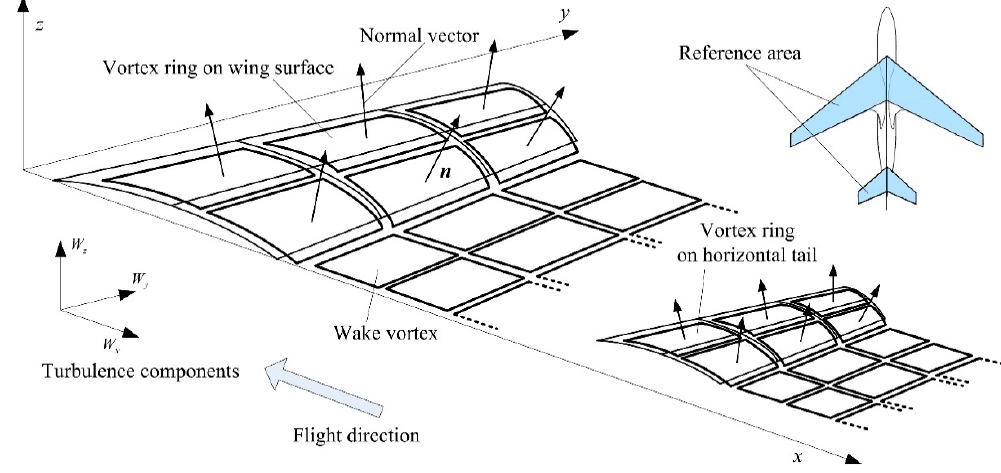
Figure 2. Vortex rings on mean camber surface of wing–tail combination.